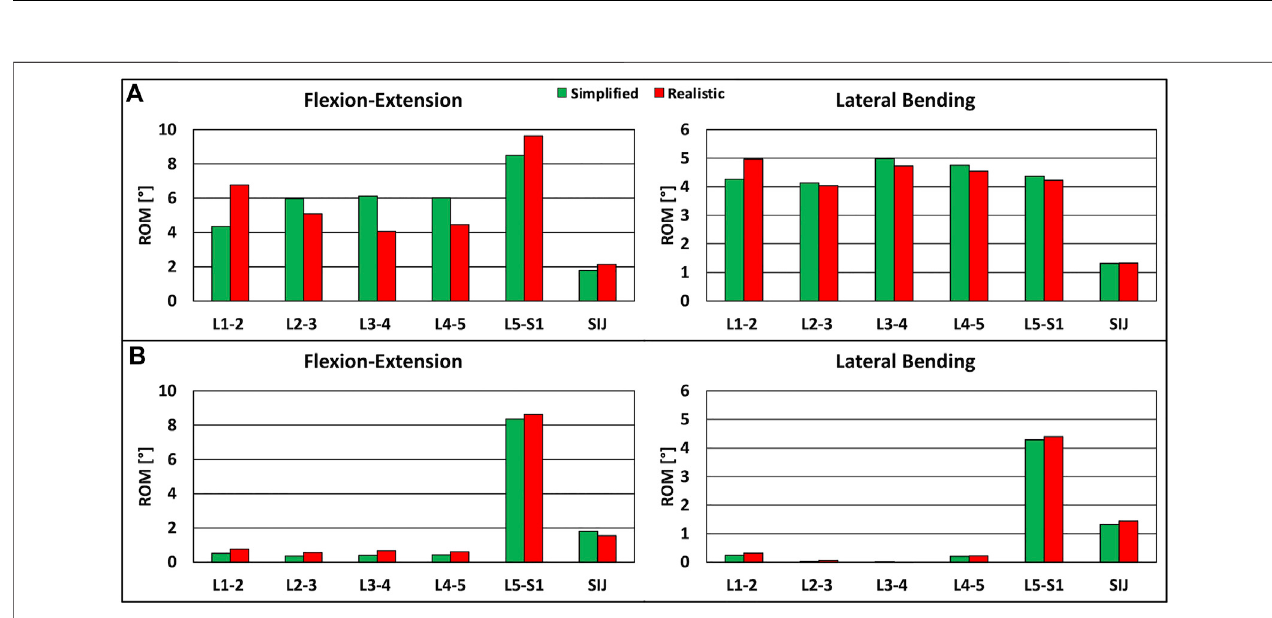
FIGURE 3 | Predicted ranges of motion of L1-S1 and sacroiliac joints under simpli fi ed loading conditions and under realistic loading conditions. (A) For the intact model in fl exion-extension (left) and lateral bending (right). (B) For the instrumented model, in fl exion-extension (left) and lateral bending (right) .